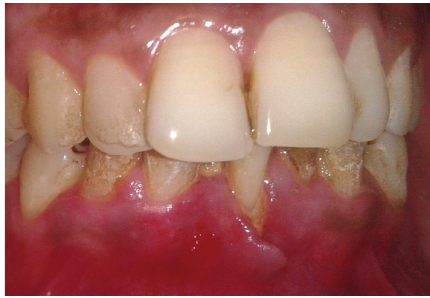
Figure 2: Case 2. Lacerated lesion due to matchstick picking involving the attached gingiva and alveolar mucosa in relation to teeth #32, #31, and